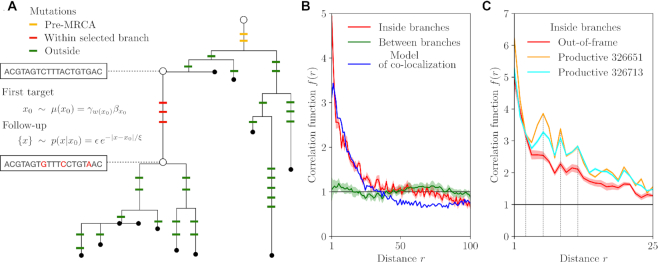
Co-localization of subsequent hypermutations. (A) Co-localization model explained on an example phylogeny. An initial mutation is drawn from the context- and position-dependent model. Then, follow-up mutations are drawn in its vicinity within the same branch. (B) Correlation function f(r) for pairs of mutations: inside (red) and between (green) branches and for simulated mutations according to the co-localization model (7) with \documentclass[12pt]{minimal}
\usepackage{amsmath}
\usepackage{wasysym}
\usepackage{amsfonts}
\usepackage{amssymb}
\usepackage{amsbsy}
\usepackage{upgreek}
\usepackage{mathrsfs}
\setlength{\oddsidemargin}{-69pt}
\begin{document}
}{}$\epsilon =5\%$\end{document} and ξ = 10. (C) Co-localization of subsequent hypermutations in productive lineages from the two largest individuals’ datasets (ID = 326651 and ID = 326713). Correlation function f(r) for pairs of mutations inside branches compared to the out-of-frame result. The first multiplicities of the codon frame length, r = 3, 6, 9, 12 are marked with dotted lines to guide the eye. Shaded areas represent \documentclass[12pt]{minimal}
\usepackage{amsmath}
\usepackage{wasysym}
\usepackage{amsfonts}
\usepackage{amssymb}
\usepackage{amsbsy}
\usepackage{upgreek}
\usepackage{mathrsfs}
\setlength{\oddsidemargin}{-69pt}
\begin{document}
}{}$95\%$\end{document} confidence intervals.